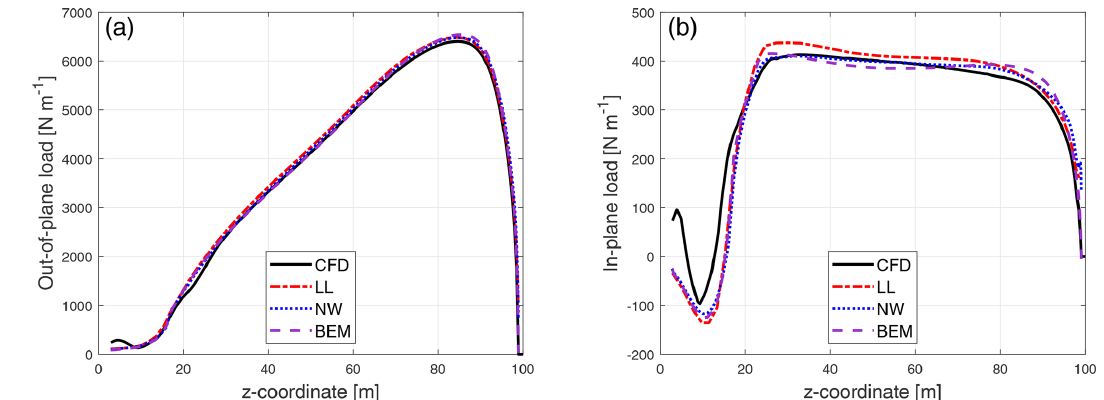
Figure 8. Comparison of out-of-plane load (a) and in-plane load (b) of the baseline straight blade calculated from the Navier–Stokes solver (CFD), the lifting-line method (LL), the proposed coupled method (NW) and the blade element momentum method (BEM).